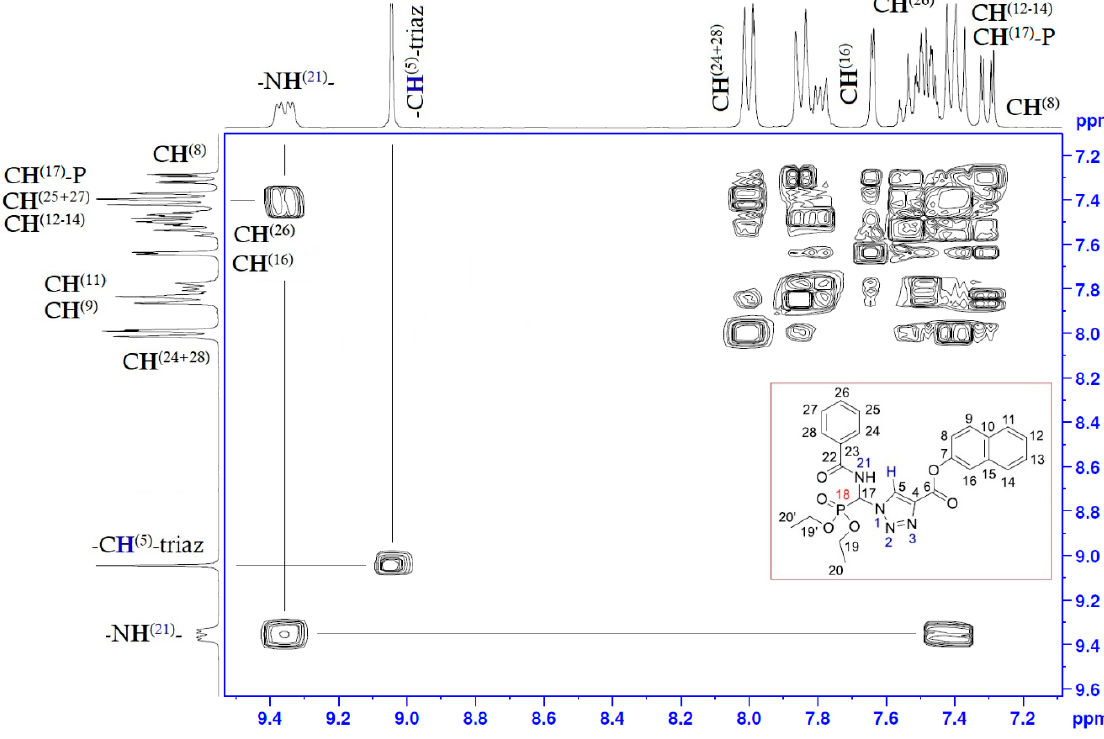
Figure 5. Two-dimensional COSY spectrum of the cycloadduct ( 3 ) ( Aromatic part ).